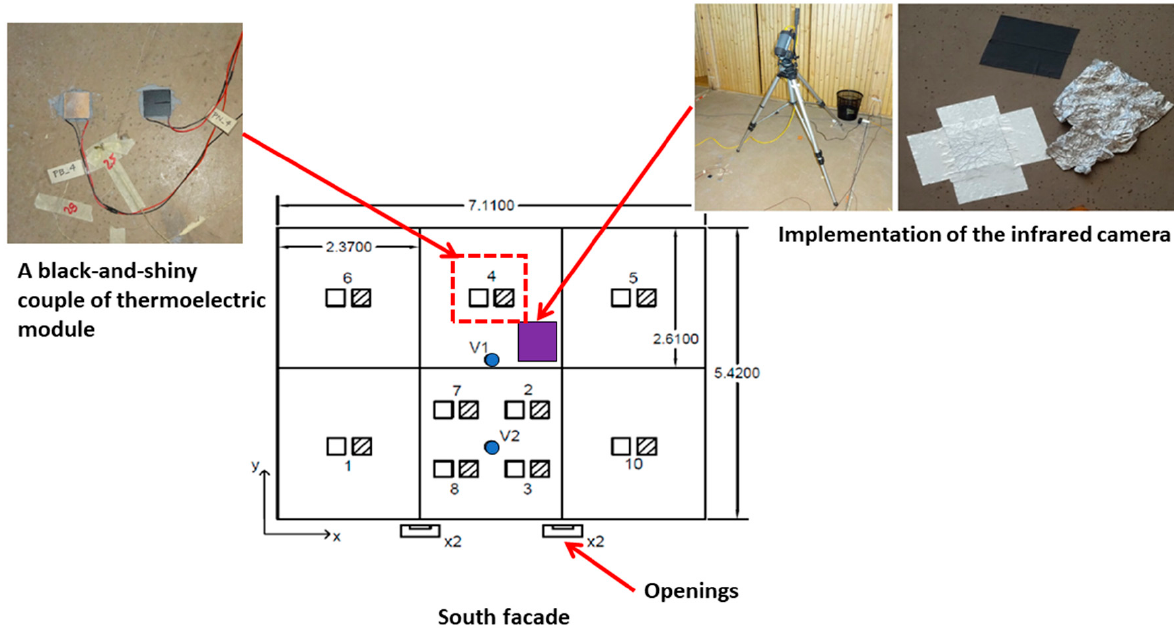
Figure 4. Instrumentation over the concrete-slab surface.